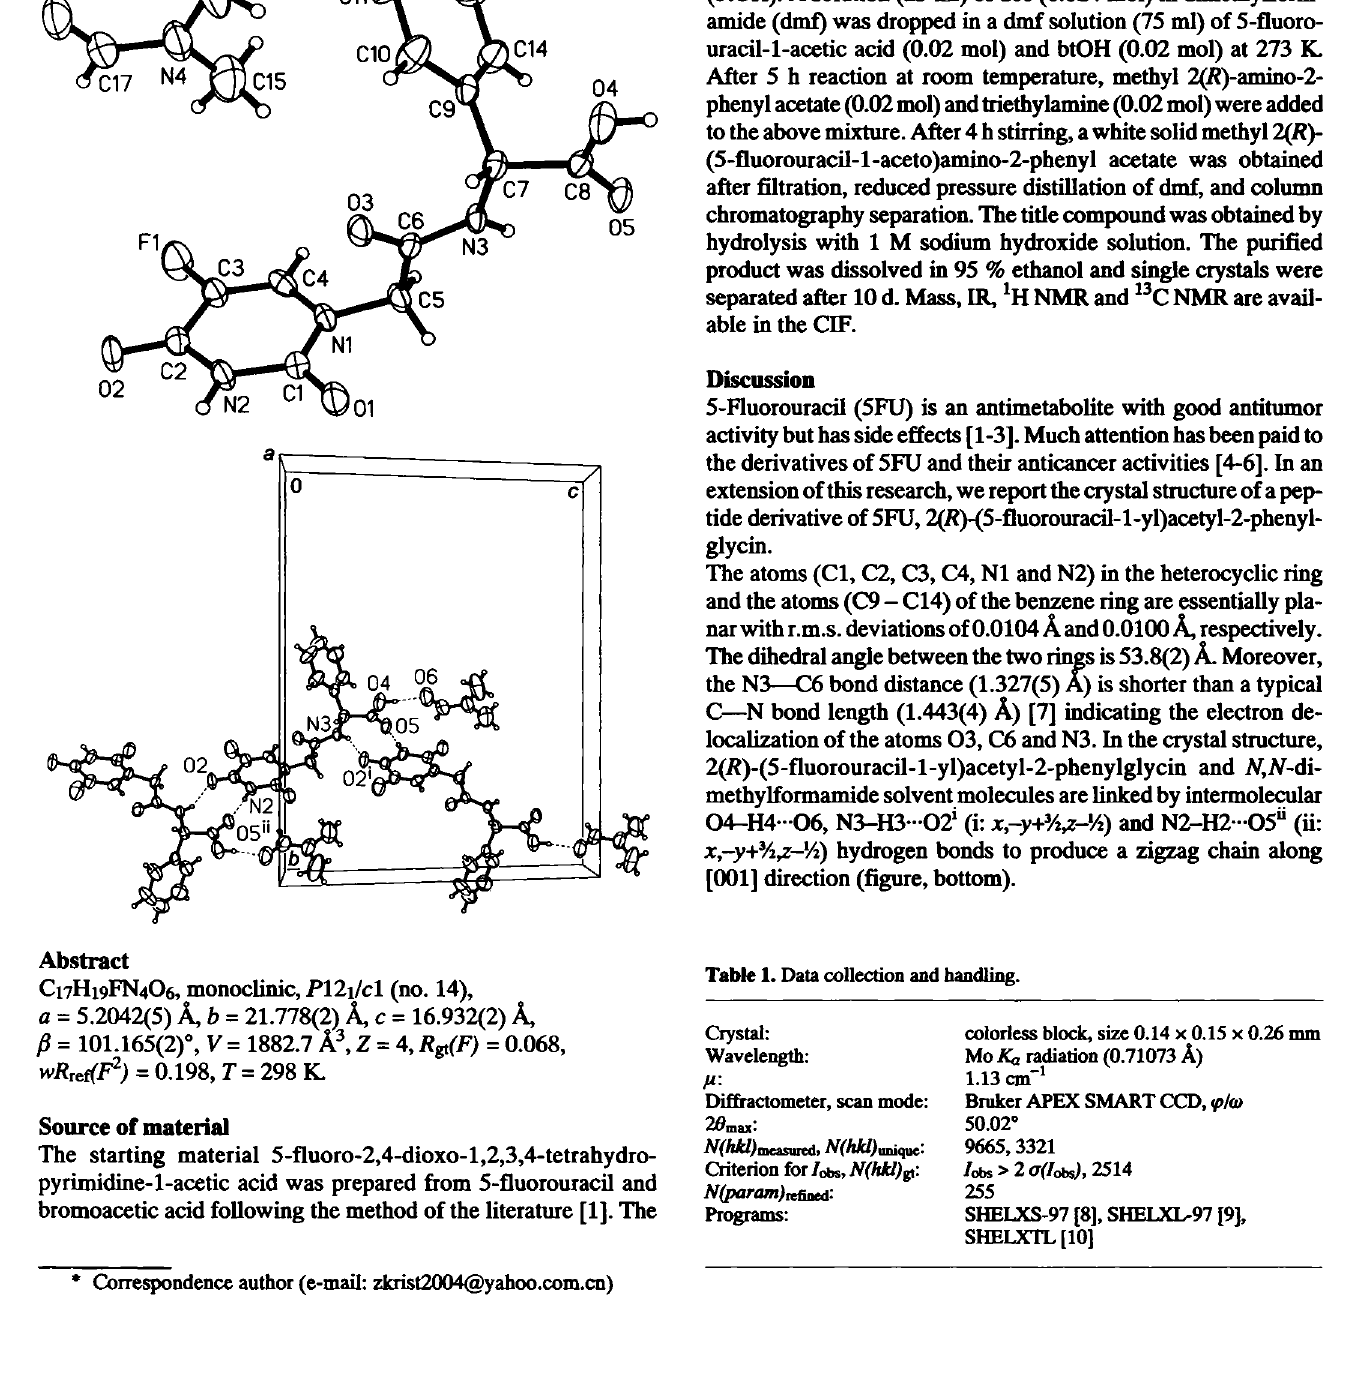
Crystal: Wavelength: μ- Diffractometer, scan mode: 2ö max